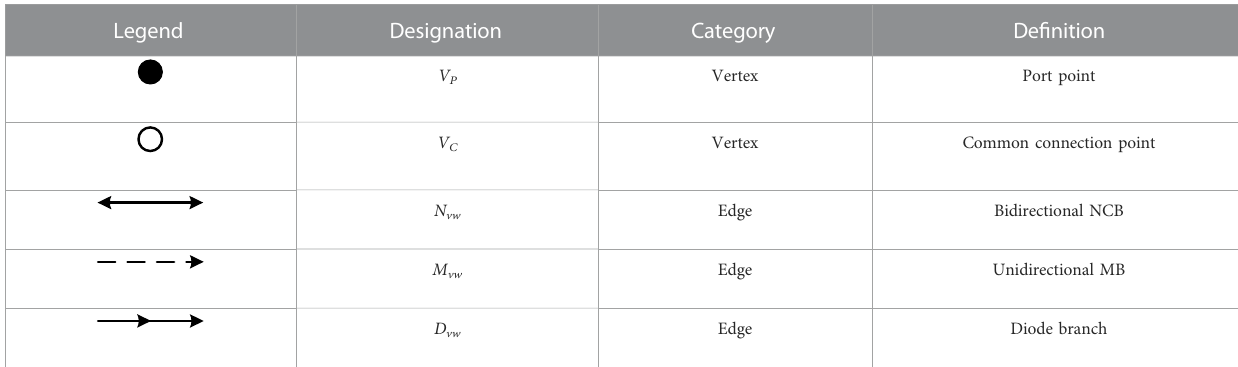
TABLE 1 Abstract rules of M-HCBs.